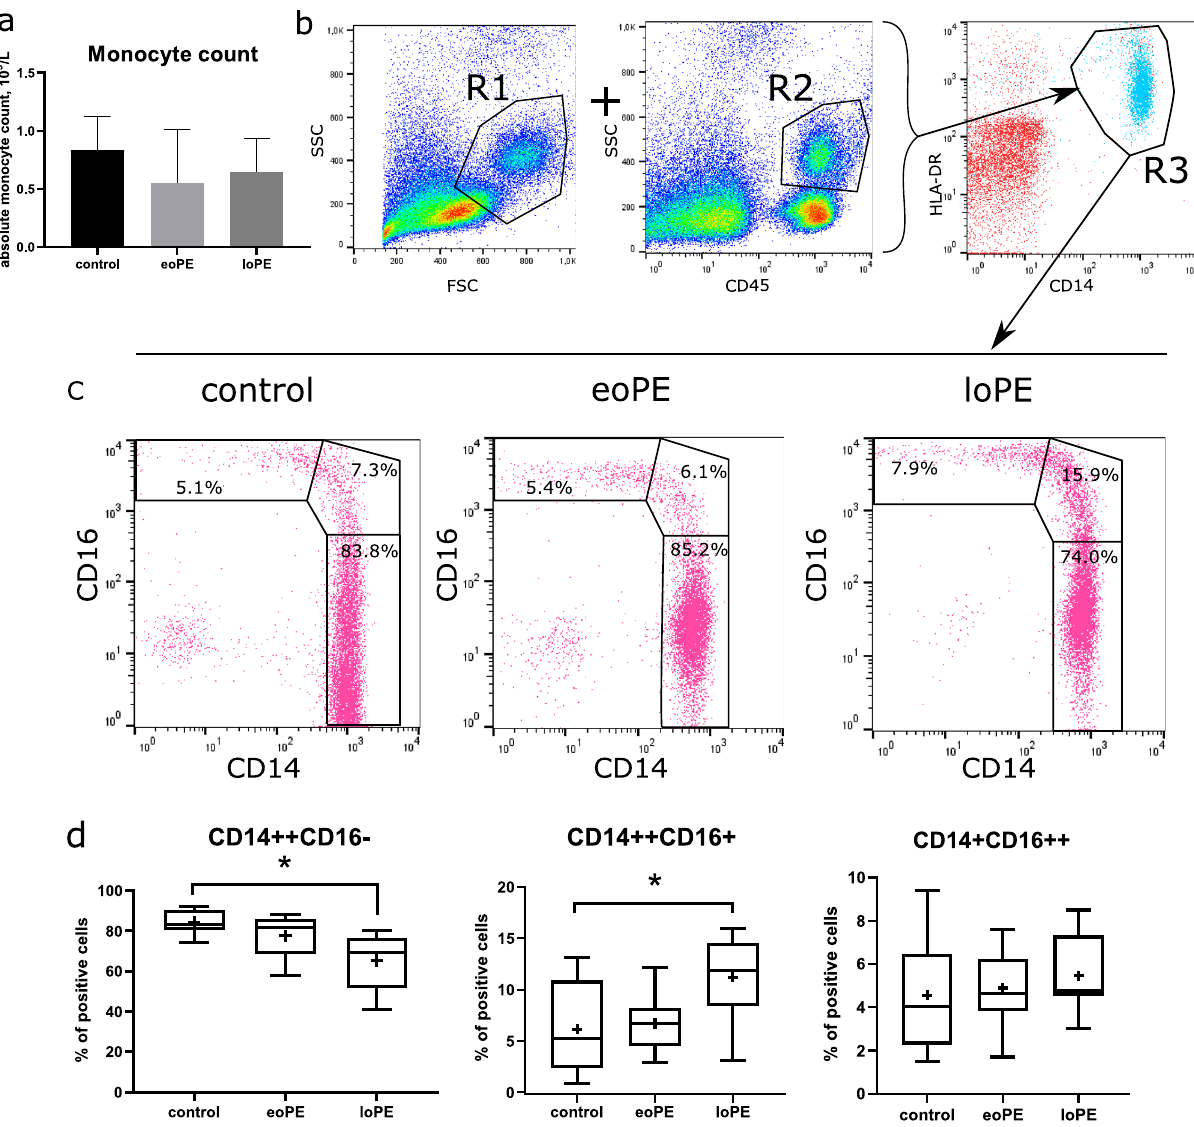
Figure 1. Characterization of the patient’s monocytes. Absolute monocyte counts for three groups of patients according to clinical diagnostic laboratory reports: the data are listed as mean ± SD ( a ). In flow cytometry analysis, monocytes were defined by sequential gating: cells that were found in both regions of interest R1 on FSC-SSC dot-plot and R2 on SSC-CD45 dot-plot, then were displayed and gated on CD14 versus HLA-DR dot-plot (R3) to exclude B lymphocytes ( b ). The selected population was analyzed in CD14–CD16 dot-plots. Representative CD14–CD16 dot-plots showing classical (CD14++CD16−), intermediate (CD14++CD16+), and non-classical (CD14+CD16++) monocytes in upper-left, middle and bottom-right regions, respectively ( c ). Boxplots of classical, intermediate, and non-classical monocyte content for three groups ( d ): eoPE early-onset PE (n = 12), loPE late-onset PE (n = 10), control (n = 11). *p < 0.05 according to Kruskal–Wallis test with Dunn’s post-hoc test; box limits are IQRs, horizontal bars are medians, and crosses are